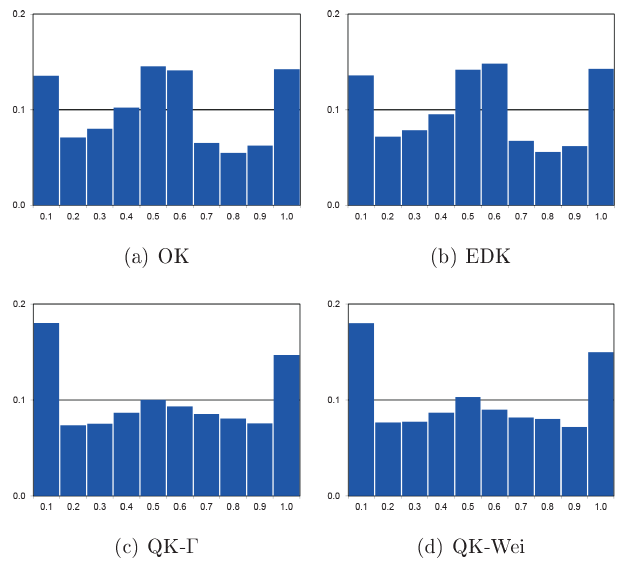
Figure 11. Histograms for the F Z ∗ -values of four different interpo- lation